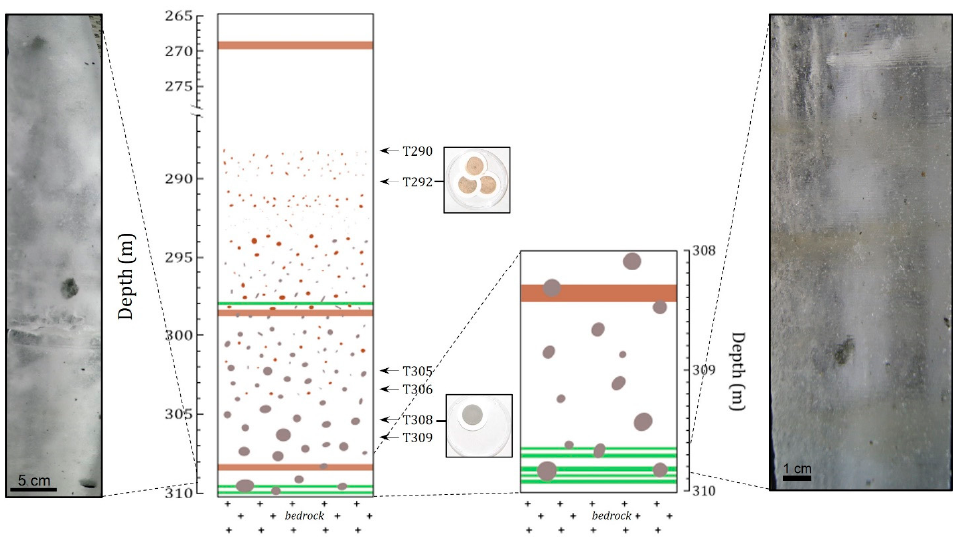
Figure A1. Simplified visual stratigraphy of the deepest 45 m of the GP ice core. Horizontal bars in the sketch mark the location of diffuse brown or greenish dust layers. Dots of various sizes symbol- ize dust particles and nodules. The grey dust nodules are larger within the deepest 5 m of the core. Note that the size of particles and nodules is not at scale in the sketch. The arrows point to the top depth of the 6 deepest 1 m ice sections discussed in this paper. The color difference is still noticeable among dust filters, as shown here in small photos of T292 and T308 filters. Photos of deep ice core sections show the grey nodules (T311, left) and horizontal diffuse layers (T312, right). Bubbles are present throughout the core and extend all the way to the bedrock, confirming the ice’s meteoritic nature. The nodules’ increasing size with depth could reflect growth by aggregation with time [60]. Smaller and much less conspicuous grey nodules have been observed in shallower parts of the GP core, which are not discussed in this paper. Figure A2. Sampling scheme of the ice and filter samples from a 1 m long ice core section of GP or GS. An ice sample is the entire 1 m section comprising subsamples which have been individually analyzed for trace elements (TE), major ions, dust size and concentration and oxygen isotopes. These parameters are not discussed at the subsample resolution in this manuscript. A filter sample corre- sponds to the insoluble particles (ø > 0.22 μ m) collected by filtering all melted subsamples together on one filter.